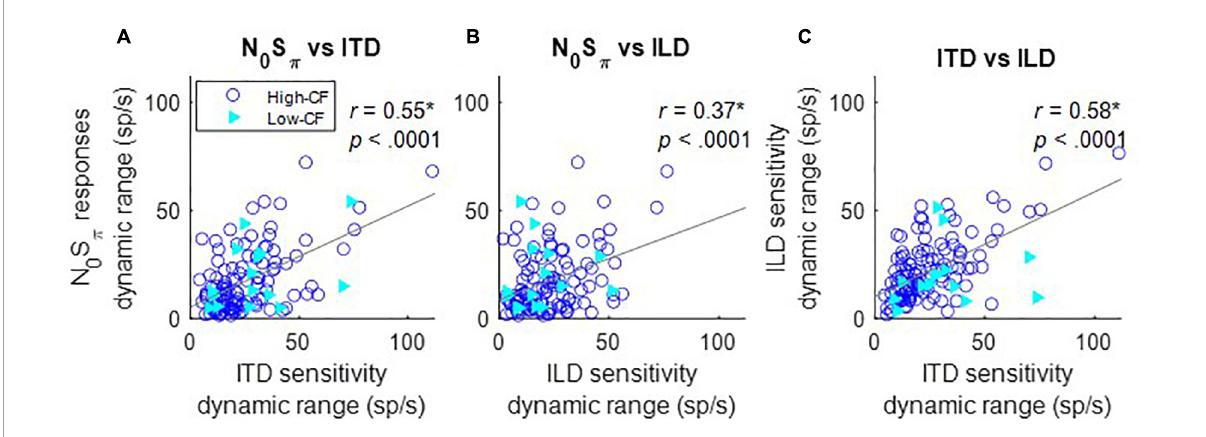
FIGURE5 Correlation between dynamic ranges of responses to N 0 S π and ITD (A) , N 0 S π and ILD (B) , and ILD and ITD (C) at 65 dB SPL (as indicated in titles). Correlation coefficients and p -values are shown at the top right of each panel; a star indicates that the correlation coefficient was significant after Bonferroni correction ( p < 0 . 017 ) . Neurons with CF below 1.5 kHz (low–CF) are shown with filled triangles, whereas neurons with CF above 1.5 kHz (high–CF) are shown with open circles. Solid gray lines indicate linear